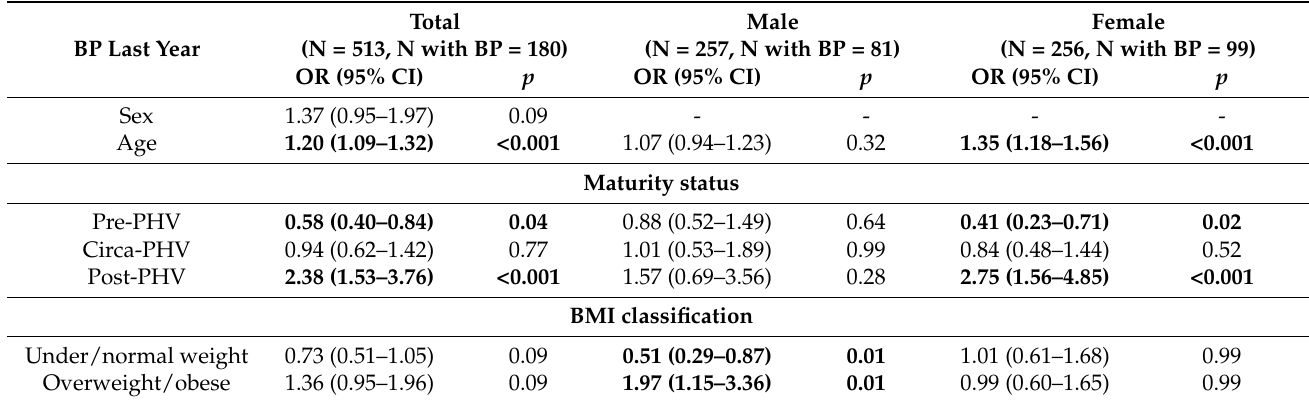
Table 2. Back pain in the last year and possible risk factors for the total sample and by sex.